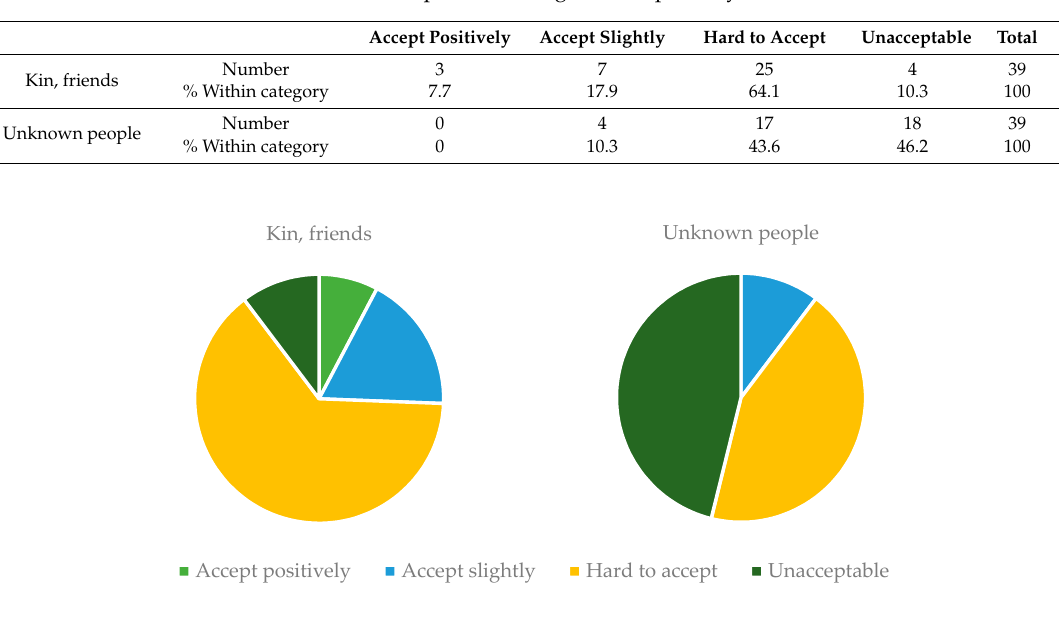
Table 4. Proportion of migrant acceptability.